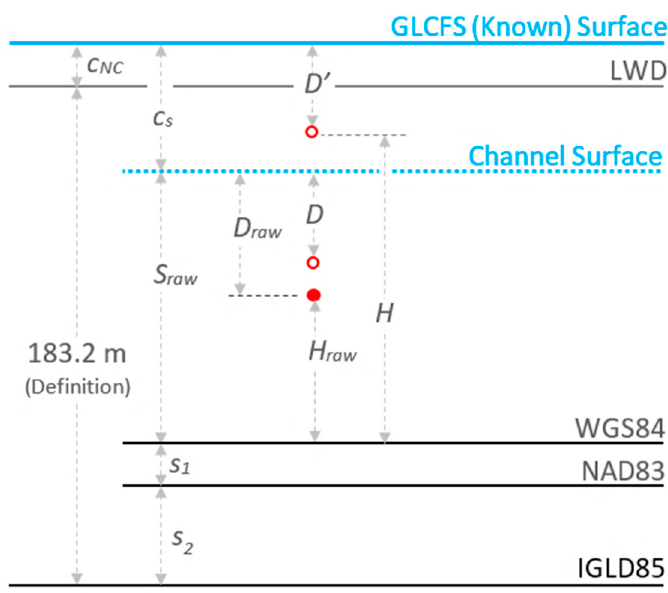
Figure 9. The vertical-control methodology used to reduce the raw bottom photon elevations to WGS84 (G1674) includes traditional hydrographic water-level corrections and modern datum-separation models.